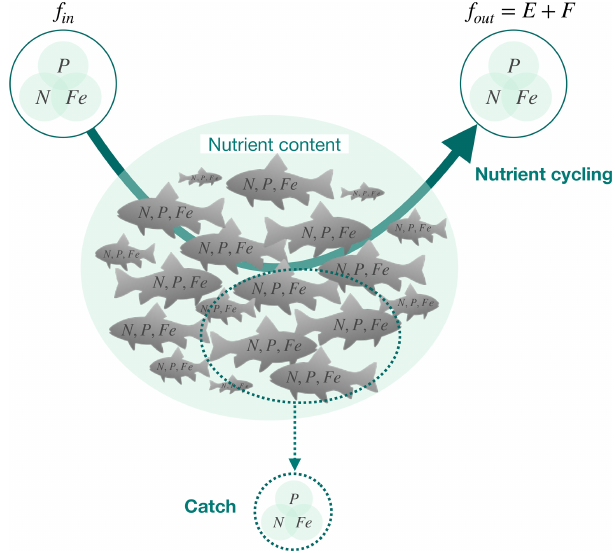
Figure 1. The ichthyosphere role in global nutrient cycling. The diagram schematically indicates the cycling of nutrients (N, P, and Fe) through the global fish biomass (solid arrow), the nutrients con- tained within the biomass, and the removal of nutrients from the ocean through fishing (dashed arrow). f in and f out are the fluxes in and out of the global fish biomass, respectively. E indicates ex- cretion (release of dissolved compounds), and F indicates egestion (release of solid